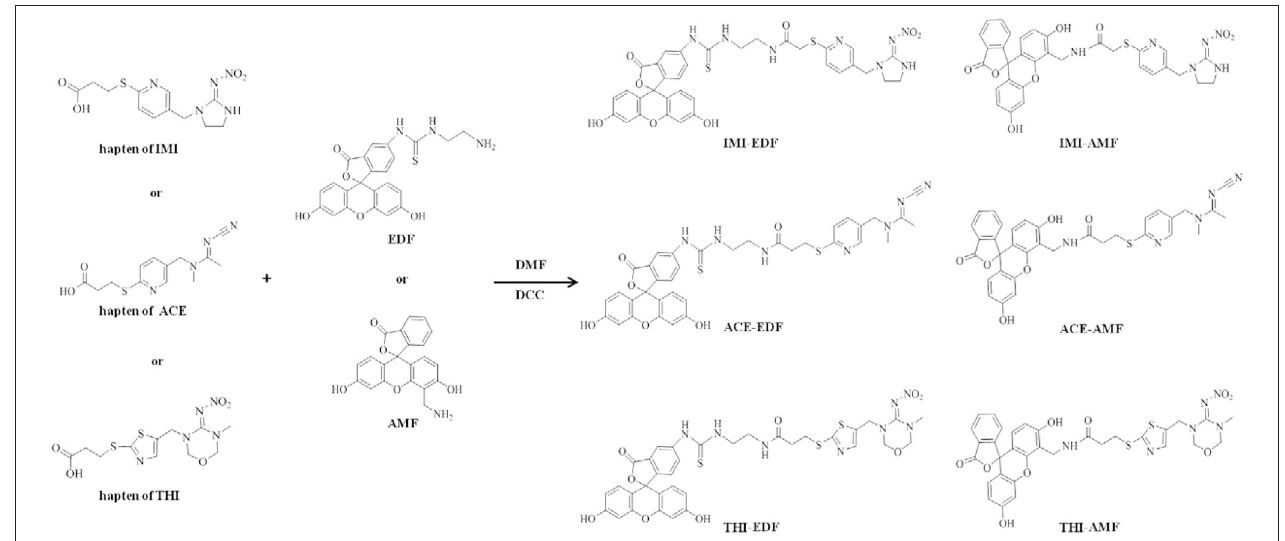
FIGURE 1 | Synthesis of fluorescent tracers.